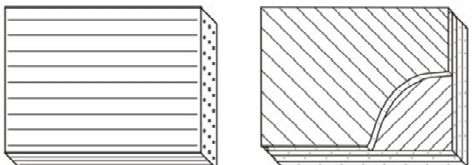
Figure 1. Representation of composite materials, showing the reinforcement fibers in different directions [5].